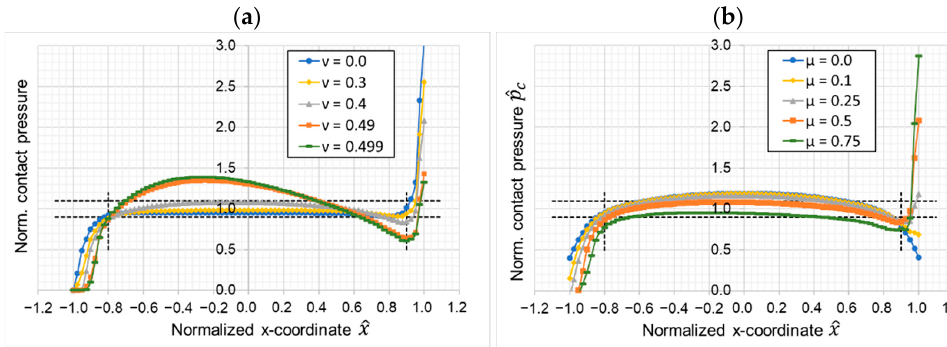
Figure 10. Influence of ( a ) Poisson’s ratio and ( b ) coefficient of friction.